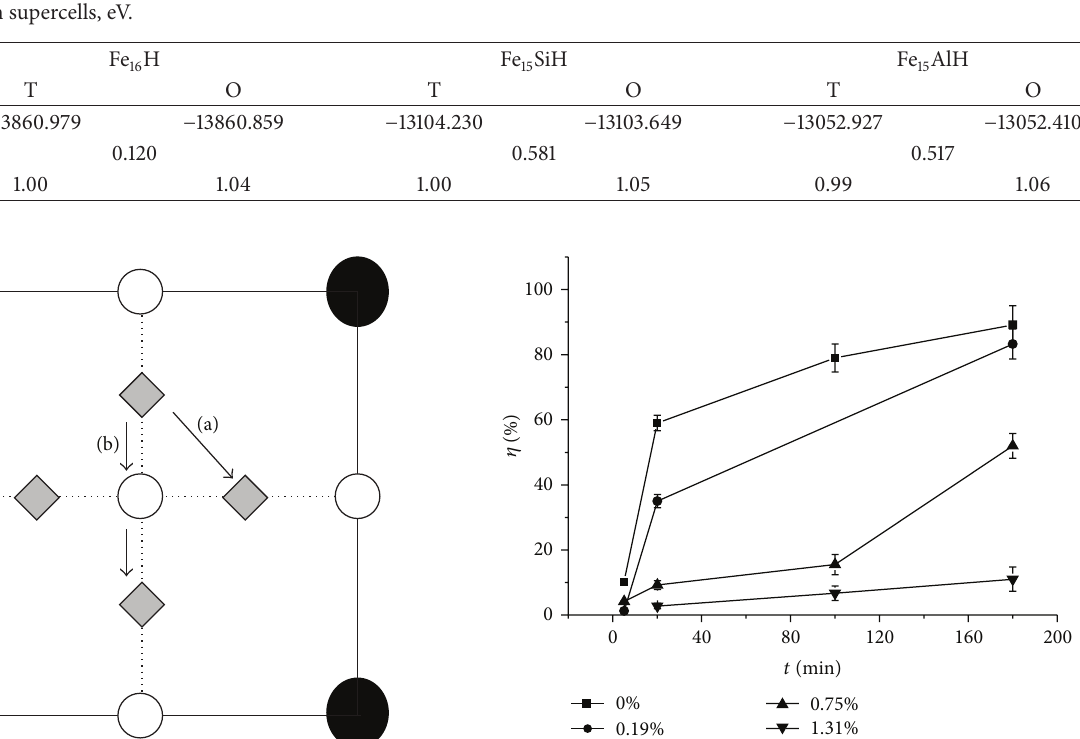
− 𝐸 ) between H in the O-site and T-site, and lattice O T